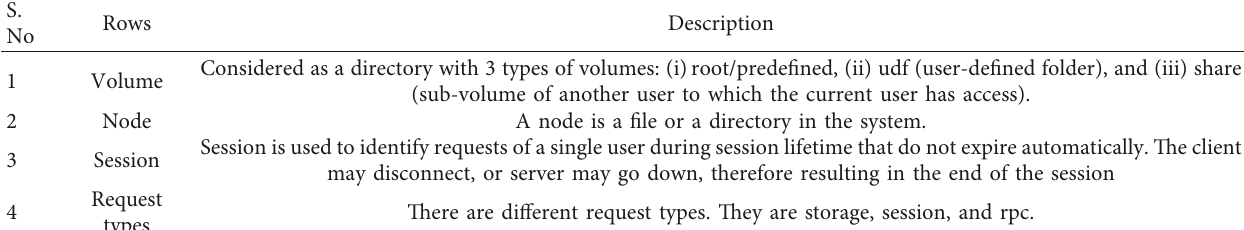
Table 1: Storage layer description.